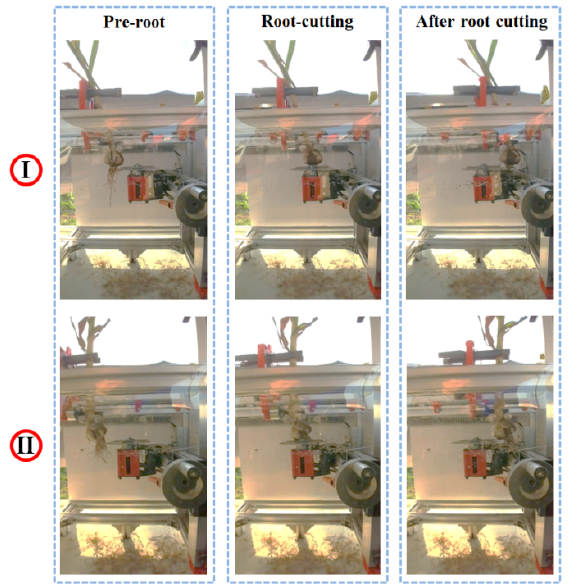
Figure 19. Field test.